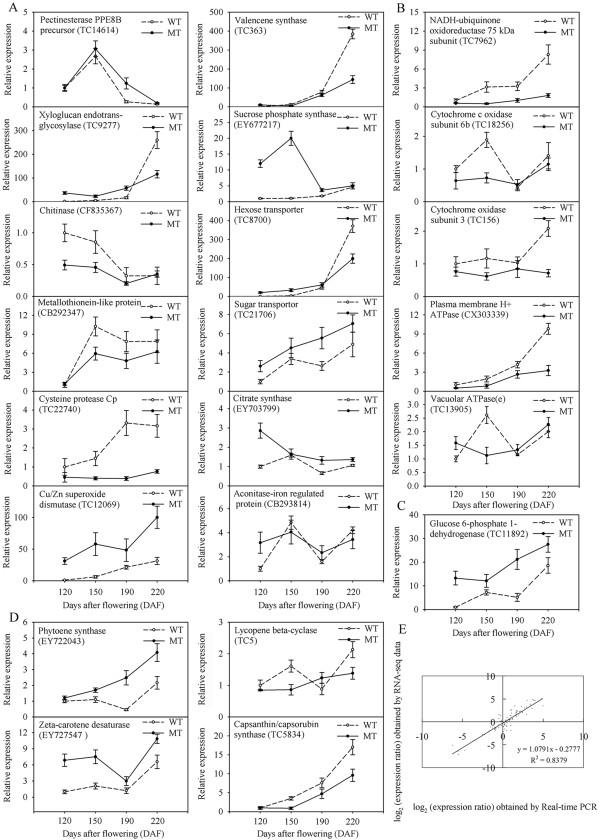
qRT-PCR validation of differential expression. The figure shows transcript levels of 22 genes, of which 12 probably associated with fruit development and ripening (A) and 10 with oxidative phosphorylation (B), the OPP pathway (C) or carotenoid biosynthesis (D) in MT (solid line) and WT (broken line). The y-axis records the relative gene expression levels analyzed by qRT-PCR. Bars represent the standard error (n = 3). (E) A comparison between the gene expression ratios obtained from RNA-seq data and qRT-PCR. The RNA-seq log2 of expression ratio (y-axis) have been plotted against developmental stages (x-axis).